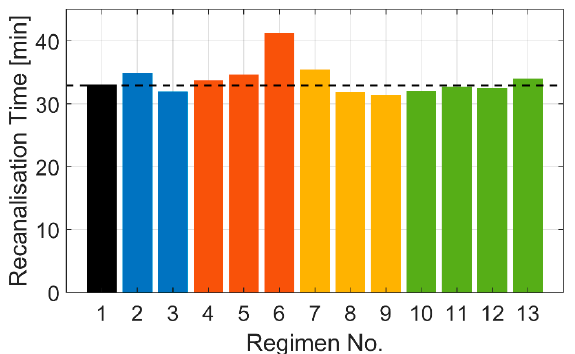
Figure 8. Predicted recanalisation times for the simulated dosage regimens. The black bar and dashed line are the reference regimen. Different colour bars indicate the therapeutic parameters that are varied: tPA dose (blue bars), bolus-infusion delay (orange), bolus-infusion ratio (yellow), and new regimens (green).